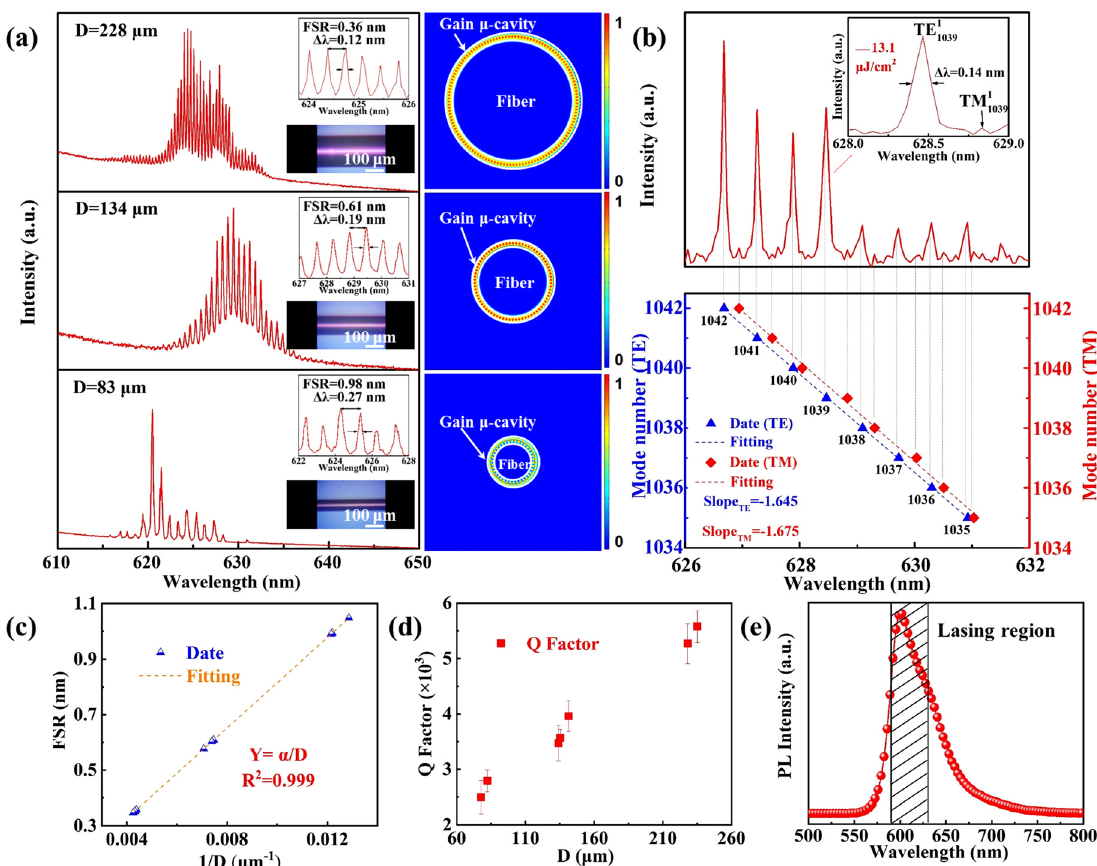
Figure 3: The relationship between lasing spectrum and diameters. (a) WGM modulation in three fibers with different diameters above the threshold. Scale bars is 100 μ m. (b) The lasing spectra is from Eq. (1). Top right illustration is the lasing peak belong to fi rst order TE and TM, and the corresponding mode count from 1035 to 1042. (c) The relationship betweenFSR and the diameterof isolated polymer fi ber D , the dashed line is fi tted with Eq. (2), α is constant.(d) The relationship between Q factor and various diameter D . (e) The spontaneous emission and the highlighted area indicates lasing